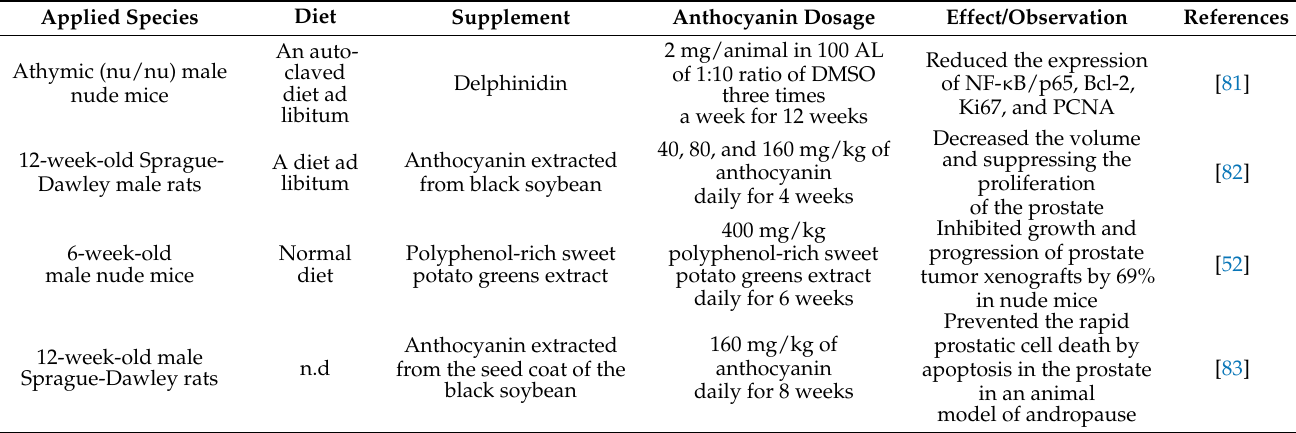
Table 2. Animal studies evaluating the effects of pure anthocyanidins/anthocyanins and extracts rich in these compounds on prostate